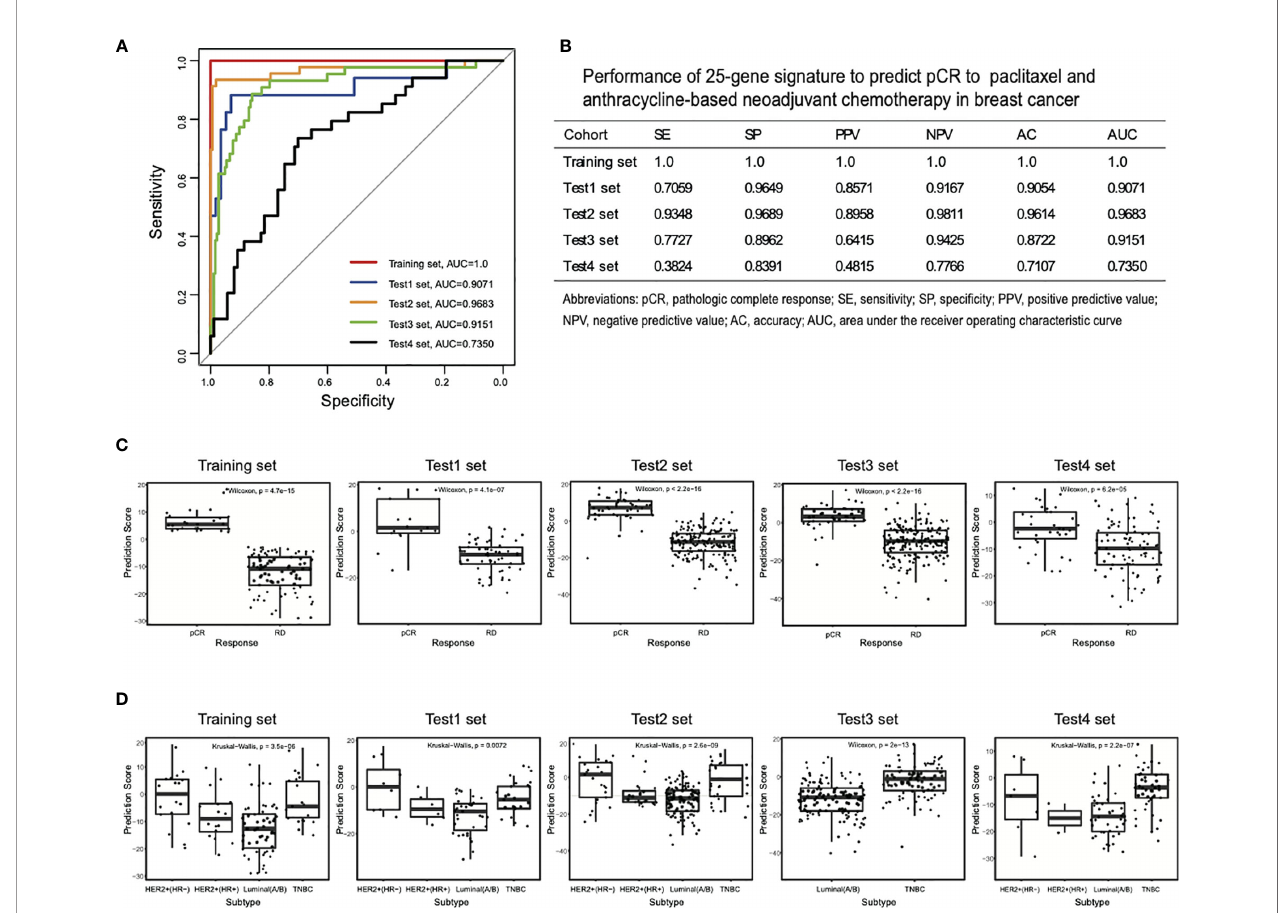
FIGURE 2 | Receiver operating characteristic (ROC) curves for the 25-gene signature classi fi er and comparison of prediction scores between pCR and RD samples. (A) ROC analyses in the training set and four test sets. (B) The performance parameters of the signature classi fi er in pCR prediction. (C) The prediction scores of the classi fi er were higher in pCR than RD samples in all training and test sets. (D) The prediction scores of HER2+ (HR − ) and TNBC subtypes were higher than those of other subtypes. pCR, pathologic complete response; RD, residual